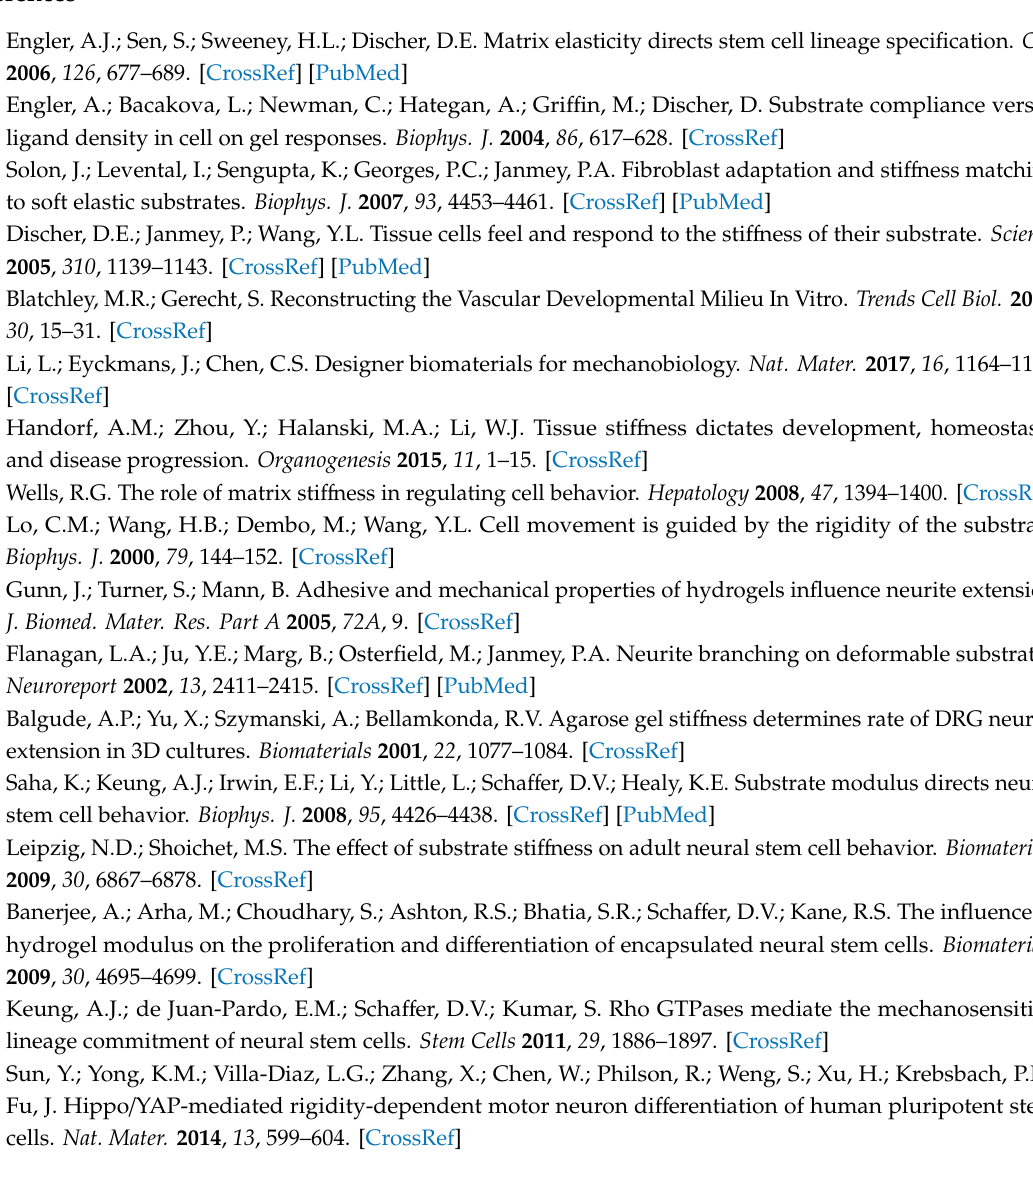
Figure S1: Stress-strain curves for PEGDA